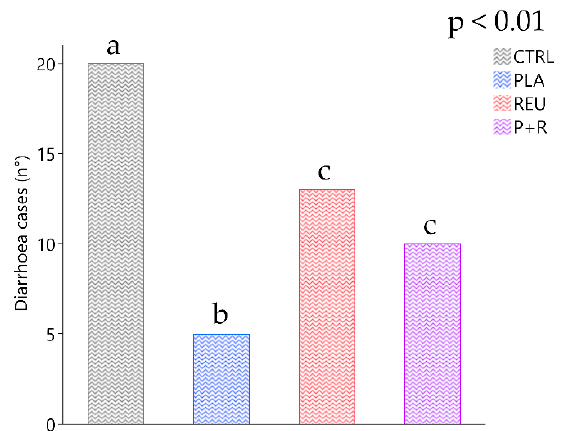
Figure 4. Total diarrhoea cases recorded during the 28-day trial for the control (CTRL) and treatment groups (PLA, REU and P+R). Data are expressed as the sum of recorded cases of diarrhoea, considering a faecal score ≥ 2 diarrhoea; a,b,c Means with different superscripts are significantly different among treatments ( p < 0.01). CTRL: control group; PLA: treatment group supplemented with 2 × 10 8 CFU/g of L. plantarum ; REU: treatment group supplemented with 2 × 10 8 CFU/g of L. reuteri; P+R: treatment group supplemented with 2 × 10 8 CFU/g of L. plantarum and L. reuteri (1:1, w / w ).